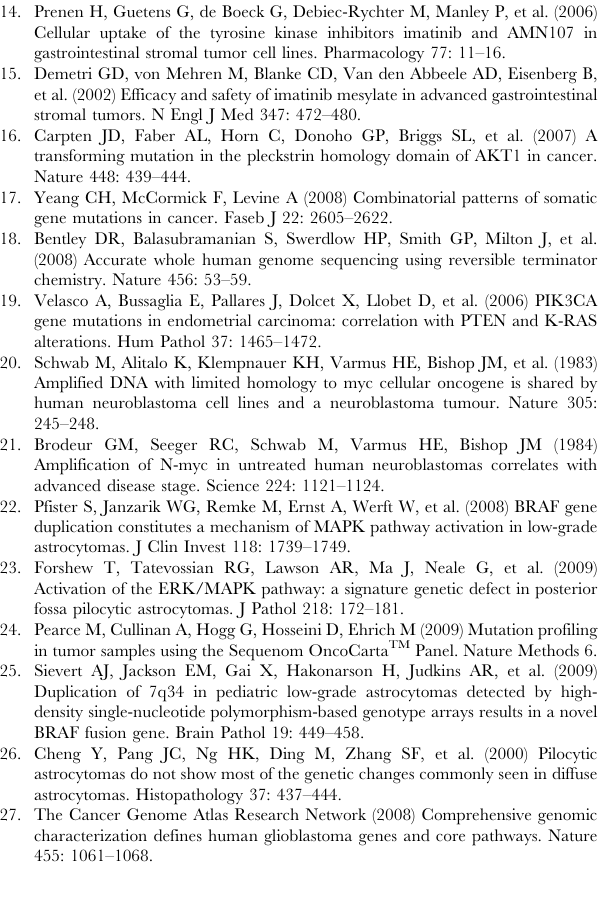
Table S2 KRAS G12 PCR primer sequences used to generate amplicons for Sanger and Illumina sequencing.